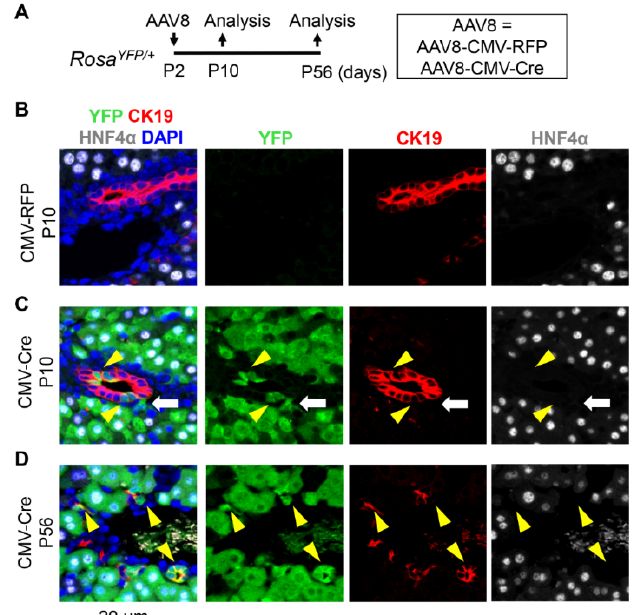
Figure 1. Labeling of cholangiocytes by injection of AAV8-CMV-Cre at P2. ( A ) Schematic representation of the treatment and analysis protocol. Rosa YFP/+ reporter mice were injected with AAV8-CMV-Cre at postnatal day 2 (P2) and tissues were analyzed at P10 and P56, respectively. ( B – D ) Immunostaining analysis. No YFP-labeled cells were detected in the liver of Rosa YFP/+ mice treated with the control vector AAV8-CMV-RFP (B). AAV8-CMV-Cre labeled CK19-expressing cholangiocytes and HNF4 α -expressing hepatocytes (C, D). Yellow arrowheads: YFP+CK19+ cholangiocytes. White arrow: YFP+ cells that do not express CK19 and HNF4 α . 4 ′ ,6-diamidino-2-phenylindole (DAPI) was used for nuclei staining.